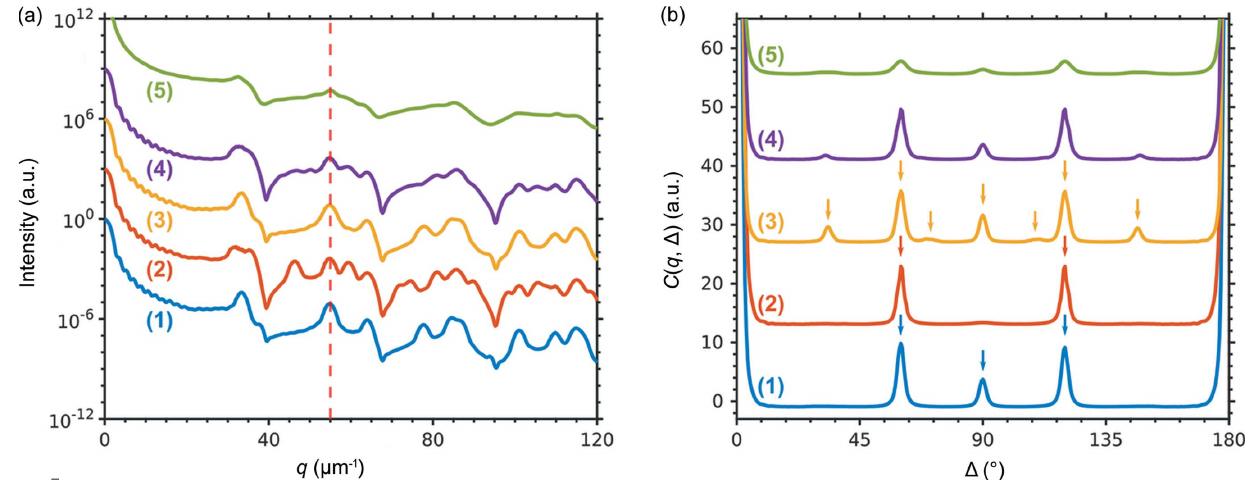
Figure 5 ( a ) Azimuthally averaged values of the 3D intensity distributions simulated for the following structures: (1) f.c.c. (2) h.c.p. (3) twinned f.c.c. domains and (4) r.h.c.p. and from the experimentally measured sample (5), for comparison. The vertical red dashed line is at q = 55 m m (cid:2) 1 corresponding to 220 f.c.c. / 110 h.c.p. Bragg peaks, for which the CCFs shown in ( b ) were calculated. ( b ) CCFs C ( q , (cid:2) ) calculated at q = 55 m m (cid:2) 1 for the simulated 3D diffraction patterns for the following structures: (1) f.c.c. (2) h.c.p. (3) two twinned f.c.c. domains and (4) r.h.c.p., and from the experimentally measured sample (5), for comparison. The arrows show the peak positions calculated for the corresponding structures by a geometrical